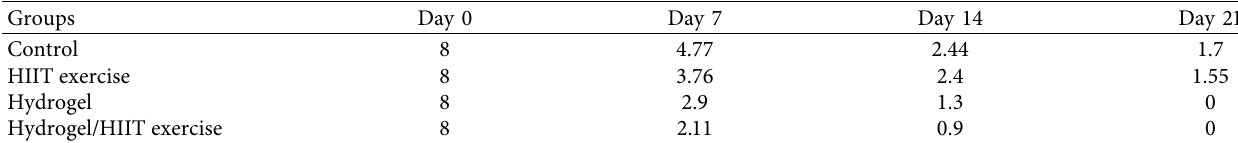
Figure 3: The rate of wound contraction in the control, HIITexercise, hydrogel, and hydrogel/HIITexercise groups on days 7, 14, and 21. Table 3: The wound contraction rate (millimeter) in 0, 7, 14, and 21 days.